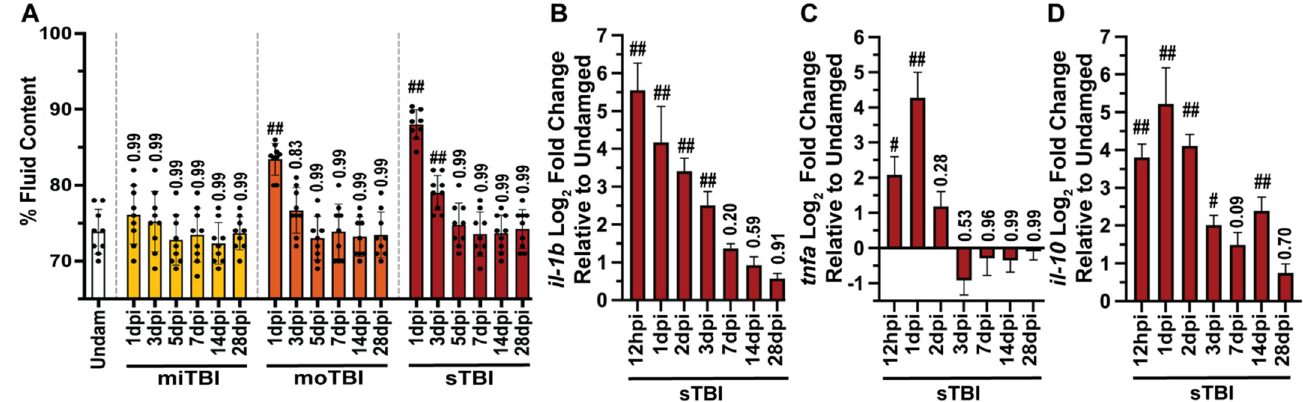
Figure 3. TBI inflicted zebrafish display edema and neuroinflammation. ( A ) Graph of level of edema, measured as the percentage of fluid in the brain, at all severities from 1–28 dpi, in which edema increased in a severity-dependent fashion, and remained elevated until 3 dpi and 5 dpi for moTBI and sTBI, respectively (n = 9). ( B , C ) Expression of pro-inflammatory cytokine genes il-1b ( B ) and tnfa ( C ) were significantly elevated in sTBI for 3 or 1 dpi, respectively, following injury before returning to near undamaged levels (5 pooled cerebellums/group, n = 3 groups). ( D ) Anti-inflammatory cytokine il-10 gene expression was also elevated and remained highly upregulated for 14 dpi (5 pooled cerebellums/group, n = 3 groups). Mean ± SEM is depicted in all graphs. Statistical analyses were performed with a One-way ANOVA followed by a Tukey’s or Dunnett’s multiple comparison post-hoc test. # p < 0.05, ## p < 0.01.